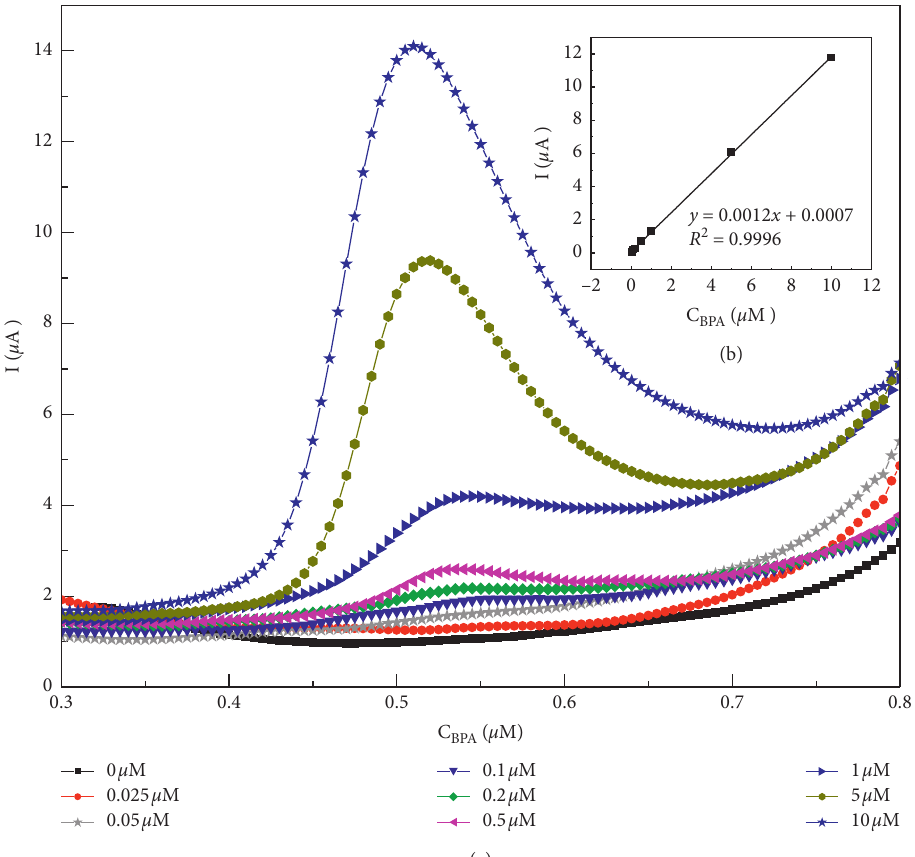
Figure 7: (a) Voltammograms recorded from BPA in the concentration range from 0.025 to 10 µ m using AuNDs/CTAB/GCE and (b) the variations of peak intensities according to the concentration